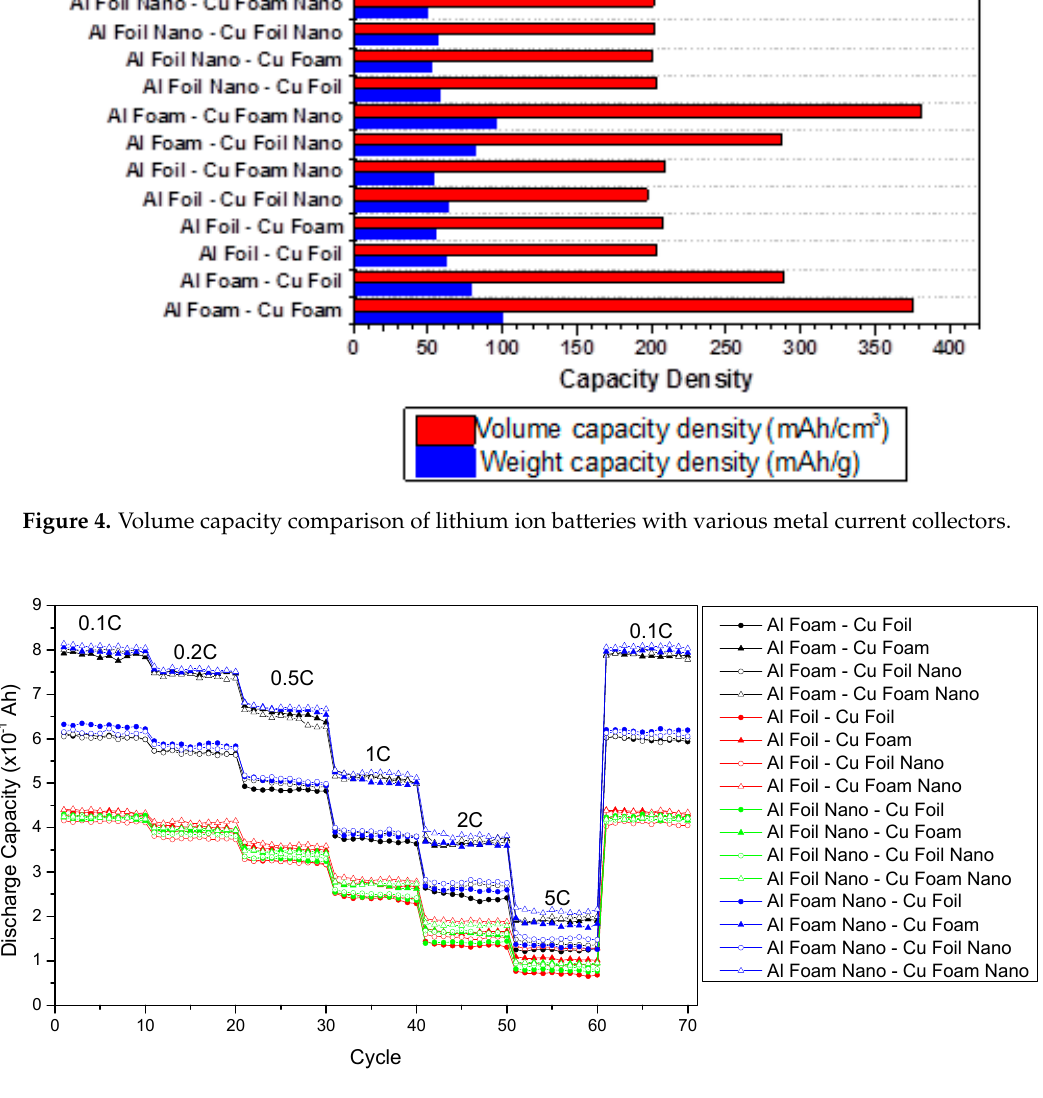
Figure 5. Cycling stability of lithium ion batteries with various metal current collectors. Table 3. Average capacity of lithium ion batteries with different current collector matches under a 5C rate.